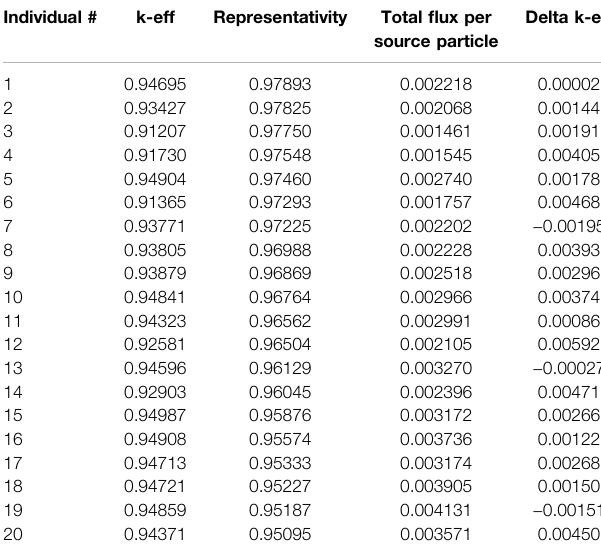
TABLE 2 | Final 20 individuals NSGA-II optimization.